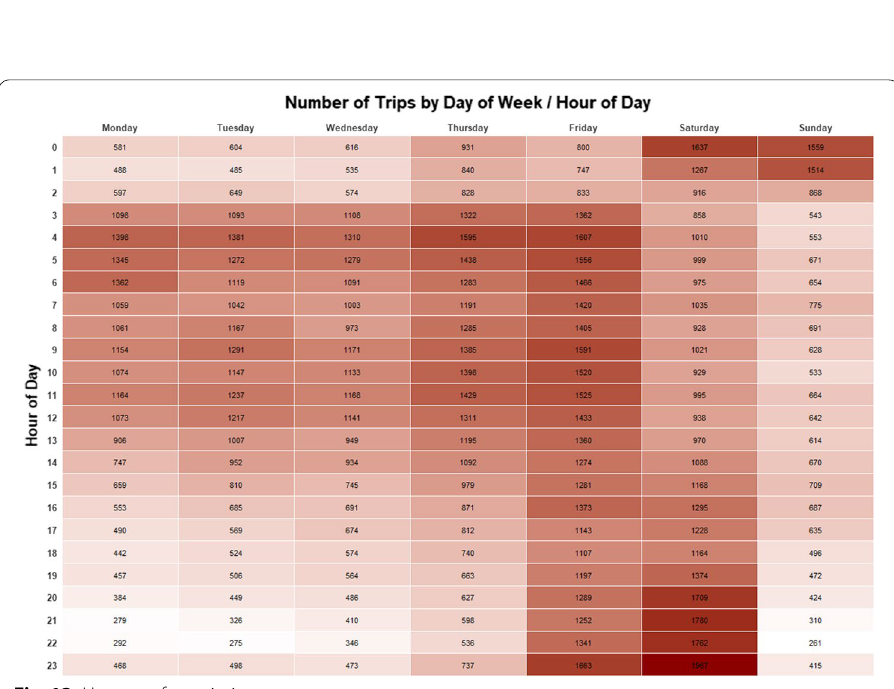
Fig. 13 Heatmap for taxi